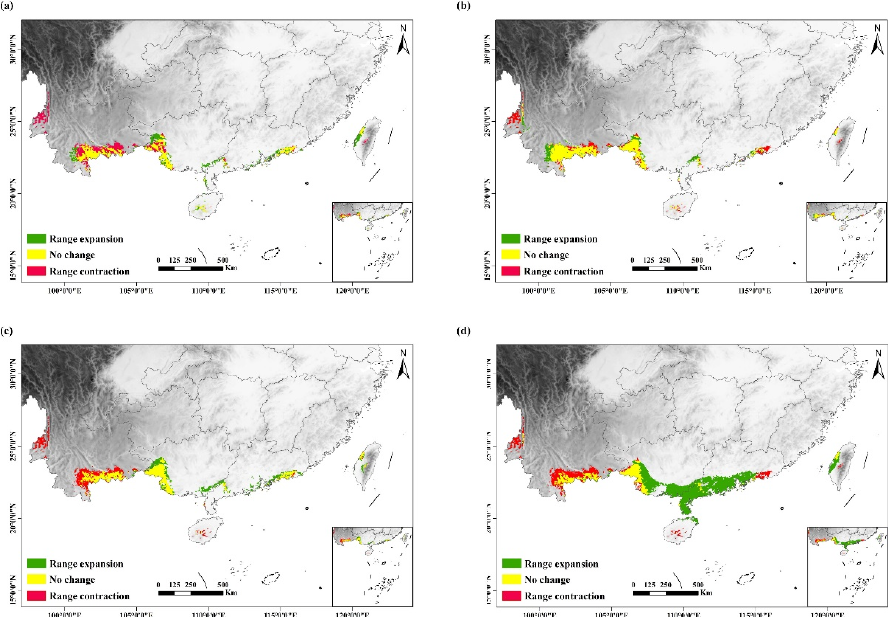
Figure 7. Habitat suitability changes from the current conditions to the future climate (2050s) under climate scenarios in MIROC6 models: ( a ) SSP 2.6, ( b ) SSP 4.5, ( c ) SSP 7.0, and ( d ) SSP 8.5. Green area marks the total expansion of habitat suitability from unsuitable to suitable habitat. Yellow area indicates habitat suitability prediction remained the same. Red area marks the contraction of suitable habitat to unsuitable.